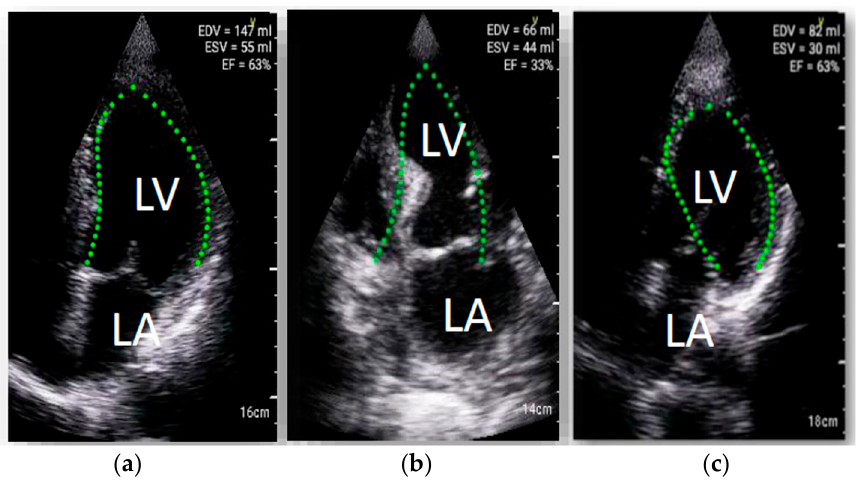
Figure 2. Examples of LVivo software implementation in patients with COVID-19; software failed